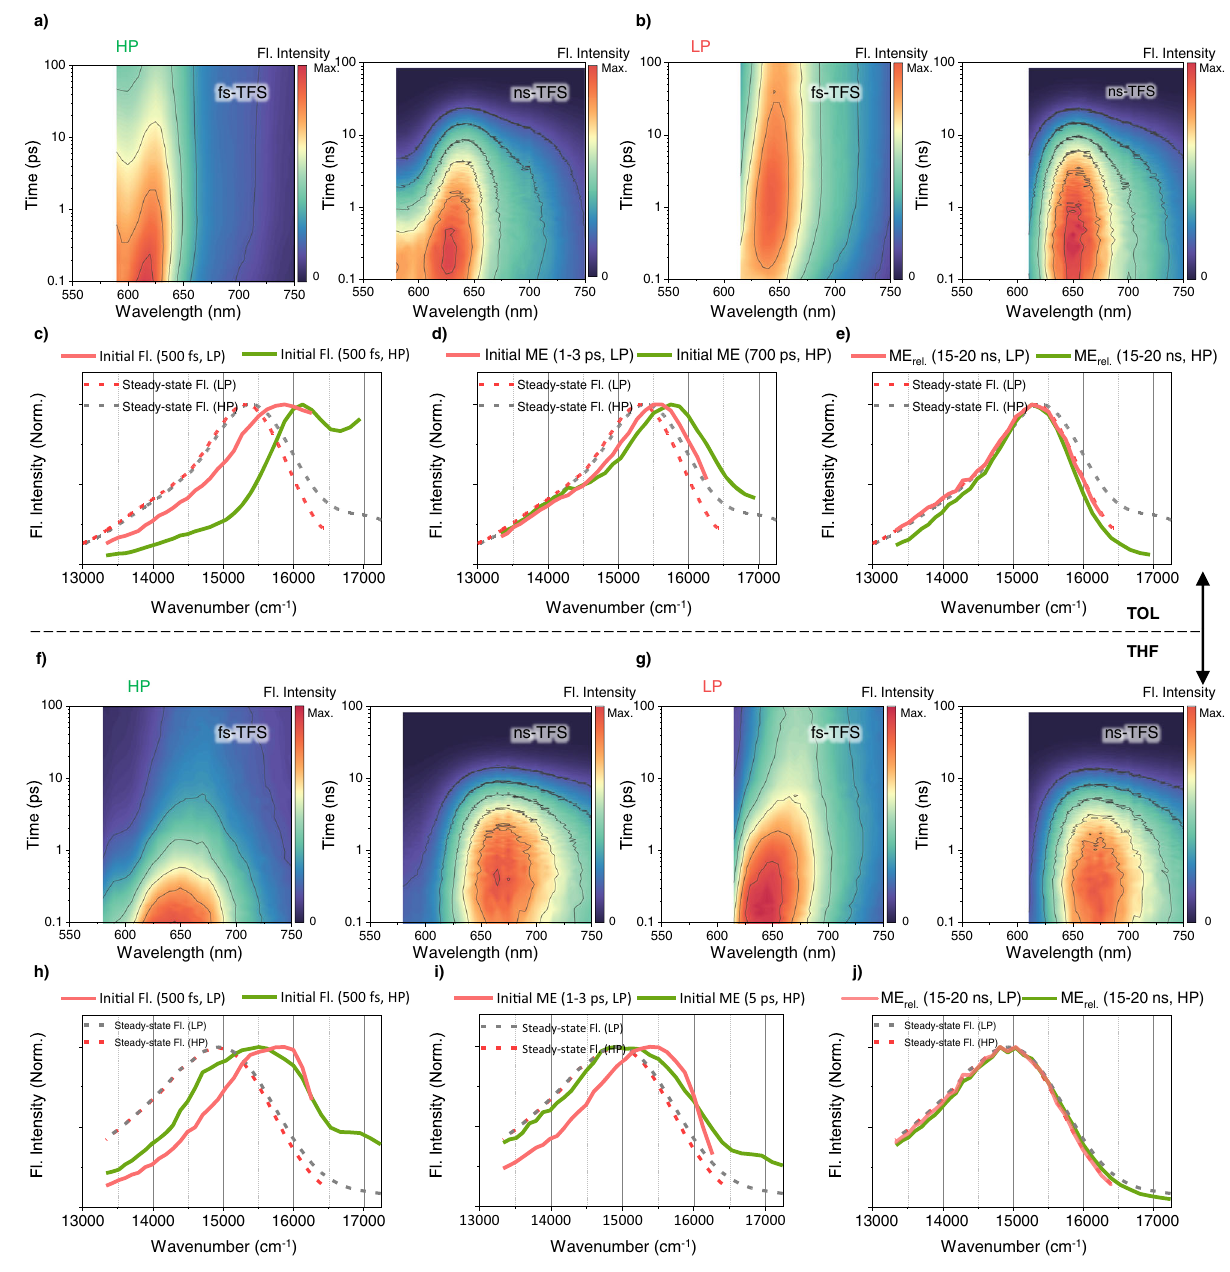
Fig. 4 | The fs-to-ns transient fl uorescence spectra (TFS) of Tris-PBI by HP (550nm,higherenergypump)andLP(600nm,lowerenergypump).a , b the fs - to- ns TFS in TOL. The 2D contour map of TFS in the range of 0.1 – 100ps (left) and 0.1 – 90ns (right) by HP ( a ) and LP ( b ). The color bar indicates the relative fl uores- cenceintensity. c - e thespectralcomparisonbetweentheFEandFE CT states( c ),the initial ME states ( d ),and the relaxedME states ( e ) in TOL by HP (green line) and LP (yellow line). The steady-state fl uorescence spectra by the HP (grey dashed line)